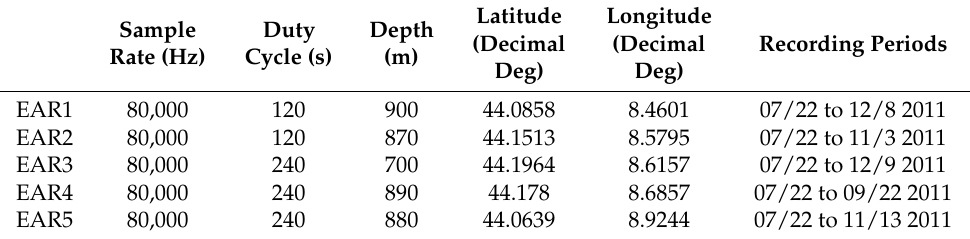
Table 1. EAR settings and recording periods of the